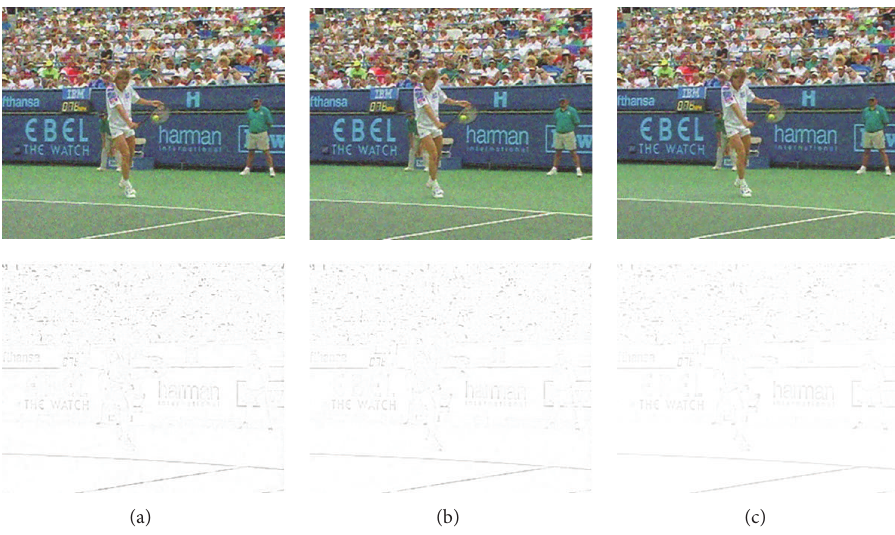
Figure 7: Filtered 20th frame of Stefan video (first row) and respective error images (second row) in case of 𝜎 2 = 0.020 noise intensity of additive noise: NLM [52] (a), VBM3D [50] (b), and FMANS 3D (c) filters. The value of each error pixel is amplified 3 times in order to distinguish the